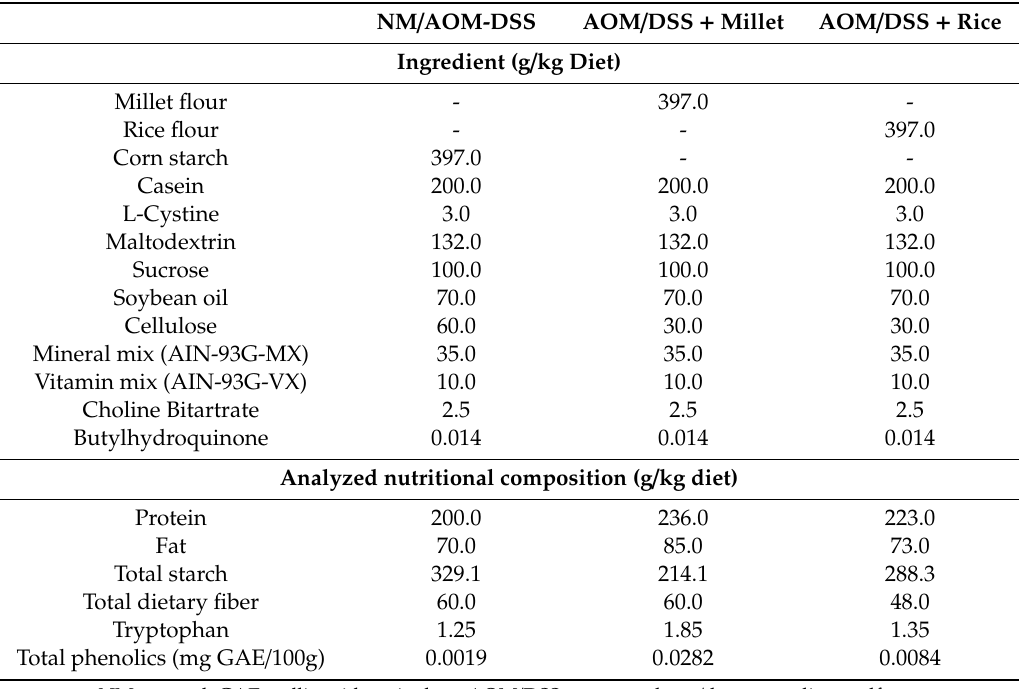
Table 1. Composition of experimental